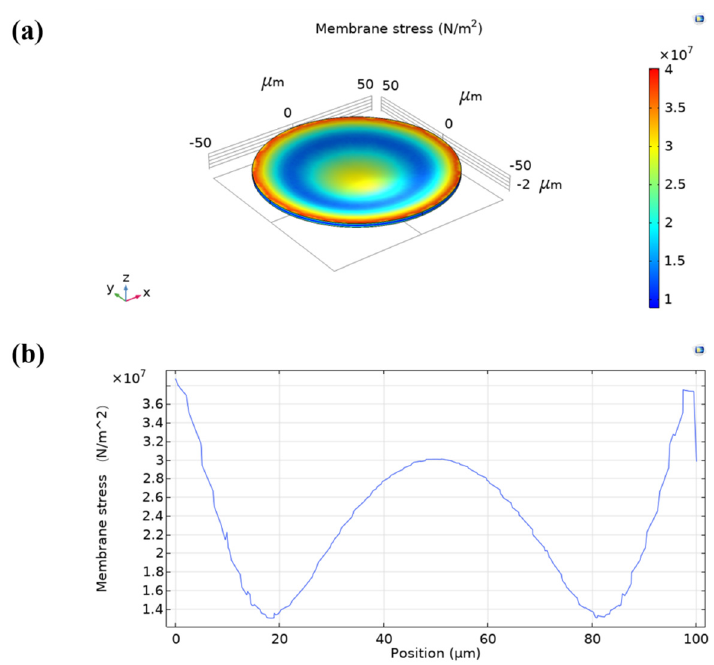
Figure 3. Membrane stress under the applied atmospheric pressure. ( a ) 3D stress contour. ( b ) Stress vs. position graph.